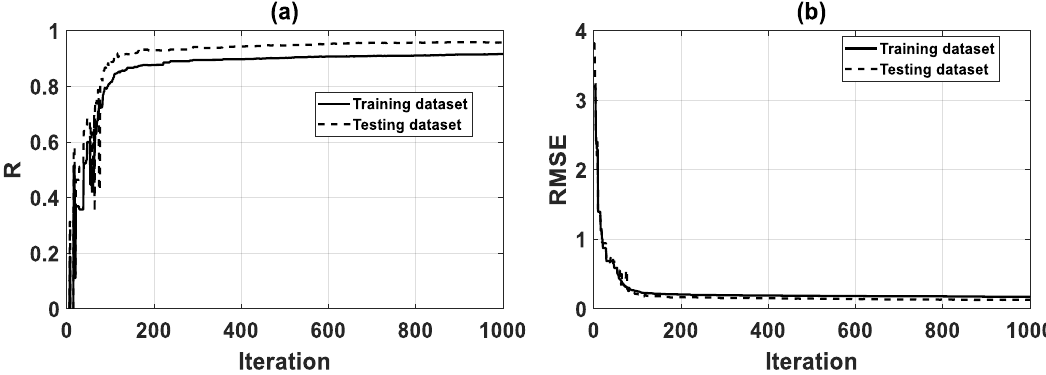
Figure 2. Convergence of optimization cost with respect to ( a ) R and ( b ) RMSE using a population size of 40.